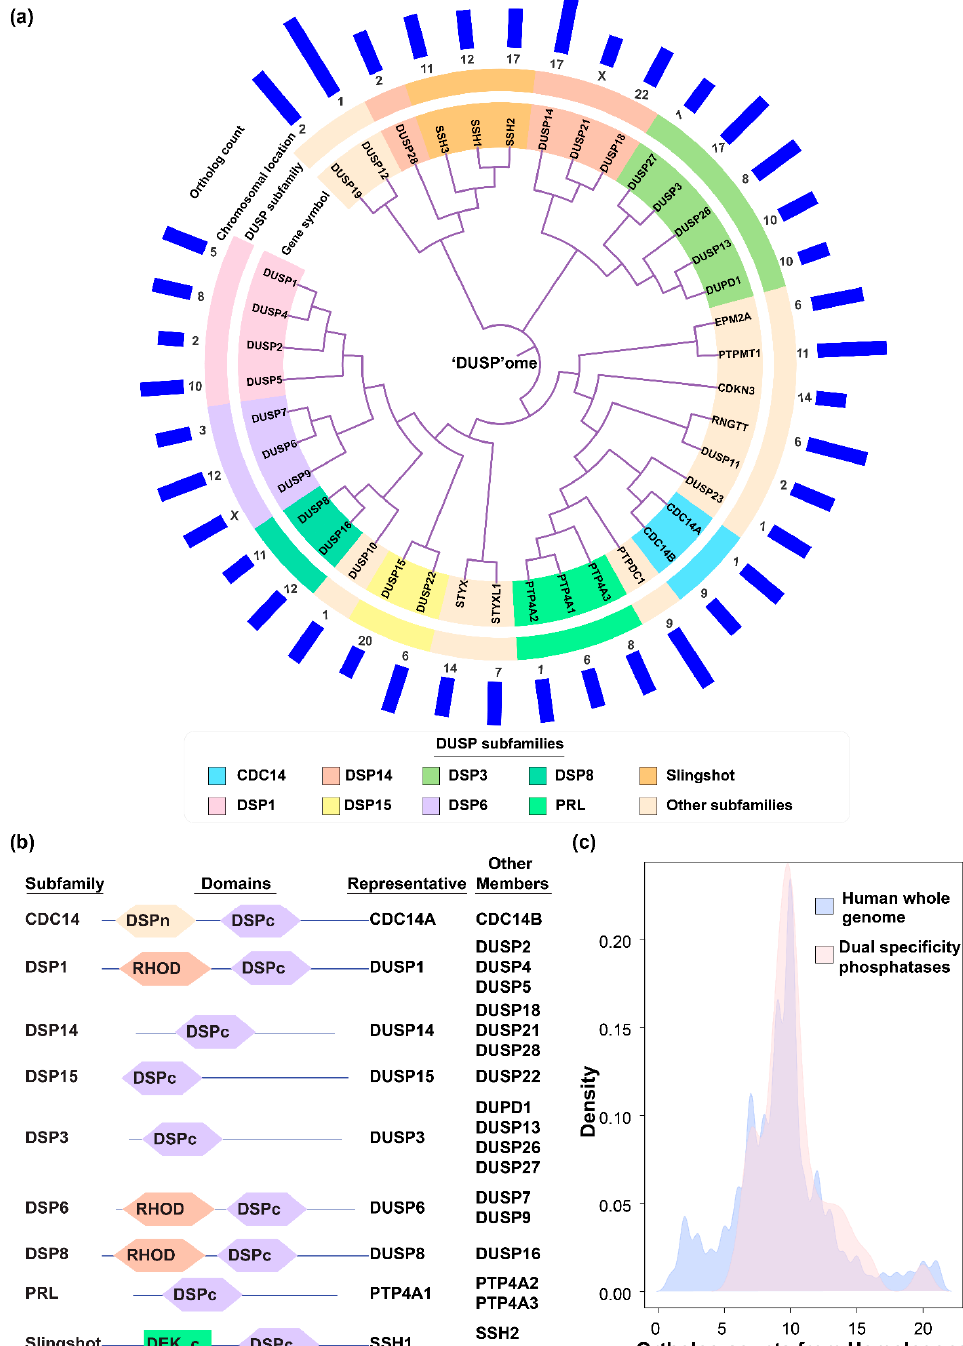
Figure 1. ( a ) Dendrogram describing the sequence similarity of members of the dual specificity phosphatase (DUSP) family. Protein sequences for various members of the dual specificity family obtained from RefSeq were aligned using Clustal Omega. The DUSPs were classified into subfamilies and their chromosomal location mapped using data and classification system from Chen et al. [7]. The tree shows largely distinct clustering of distinct DUSP subfamilies. ( b ) Domain architecture of DUSP subfamilies. Members of the DUSP family were subjected to domain analysis using SMART domain prediction. ( c ) Conservation of dual specificity phosphatases across species. Ortholog counts were obtained for all human genes from Homologene and the density of ortholog counts for DUSP family members was plotted against the density of ortholog counts for all human genes in the background. The graph largely indicates conservation of DUSPs across various